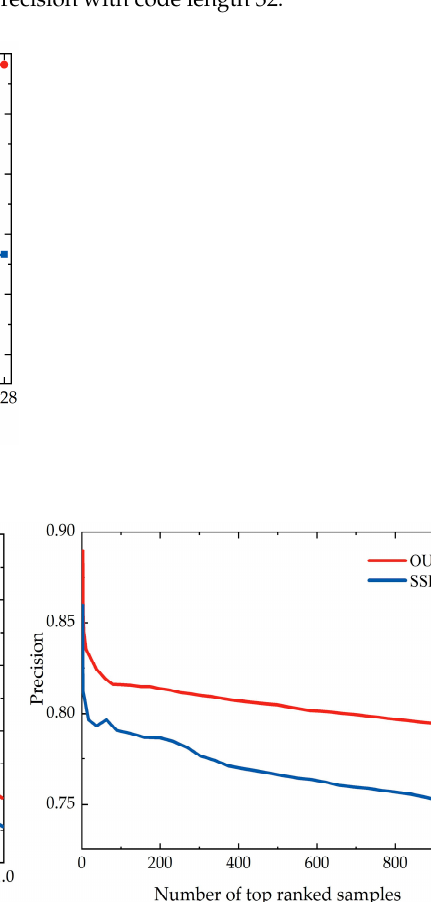
Figure 12. Precision–recall curves and top-N precision with code length 32 on visual